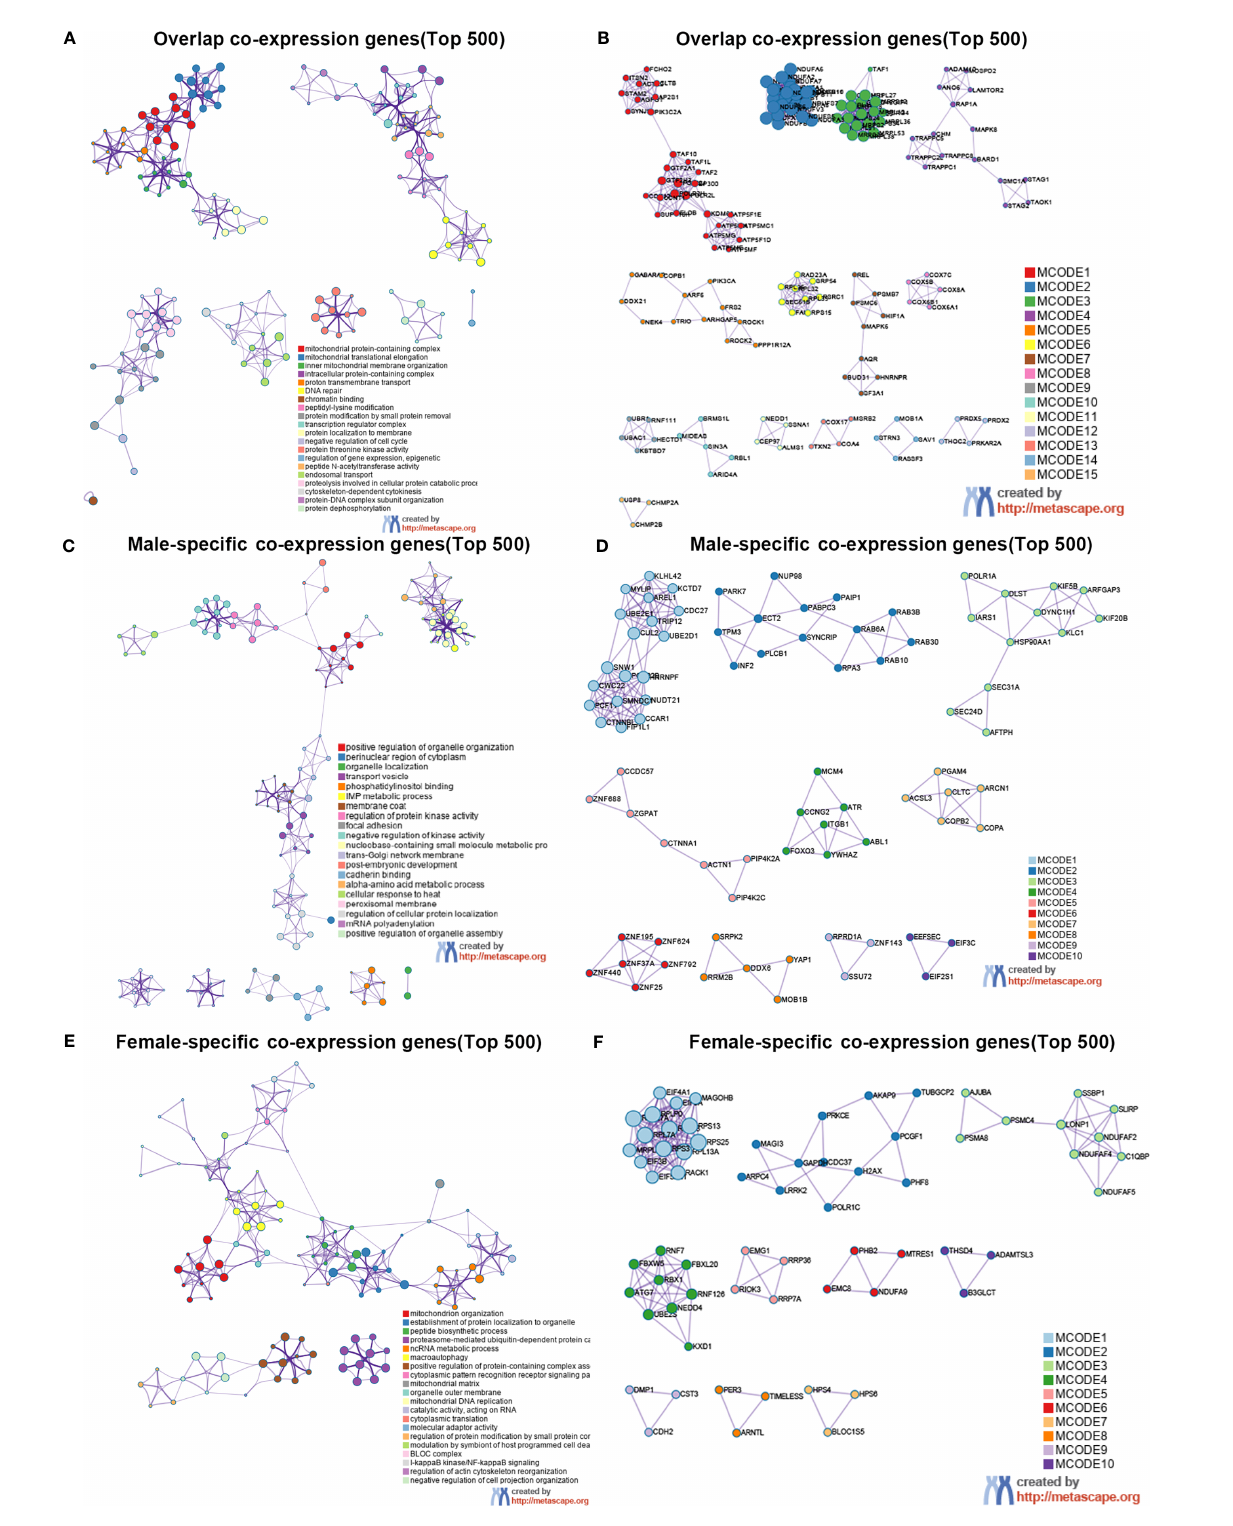
FIGURE 6 | Sex differences in the enrichment analysis of GMFB in HCC (Metascape). Network of enriched terms of top 500 overlap co-expression genes (A) , male- speci fi c co-expression genes (C) and female-speci fi c co-expression genes (E) , and colored by cluster ID. PPI network of proteins of top 500 overlap co-expression genes (B) , male-speci fi c co-expression genes (D) and female-speci fi c co-expression genes (F)